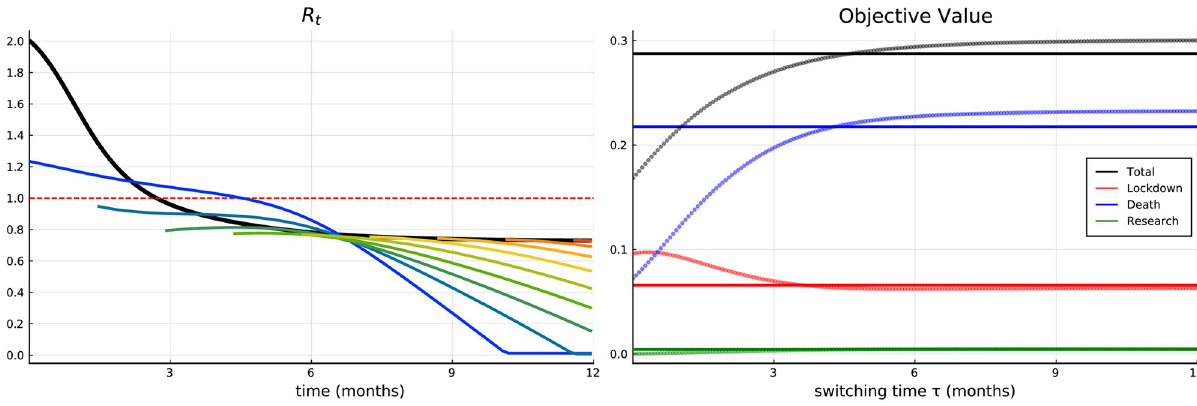
Fig 5. Scenario 1. Effective reproduction number over time (left) and decomposition of the objective value